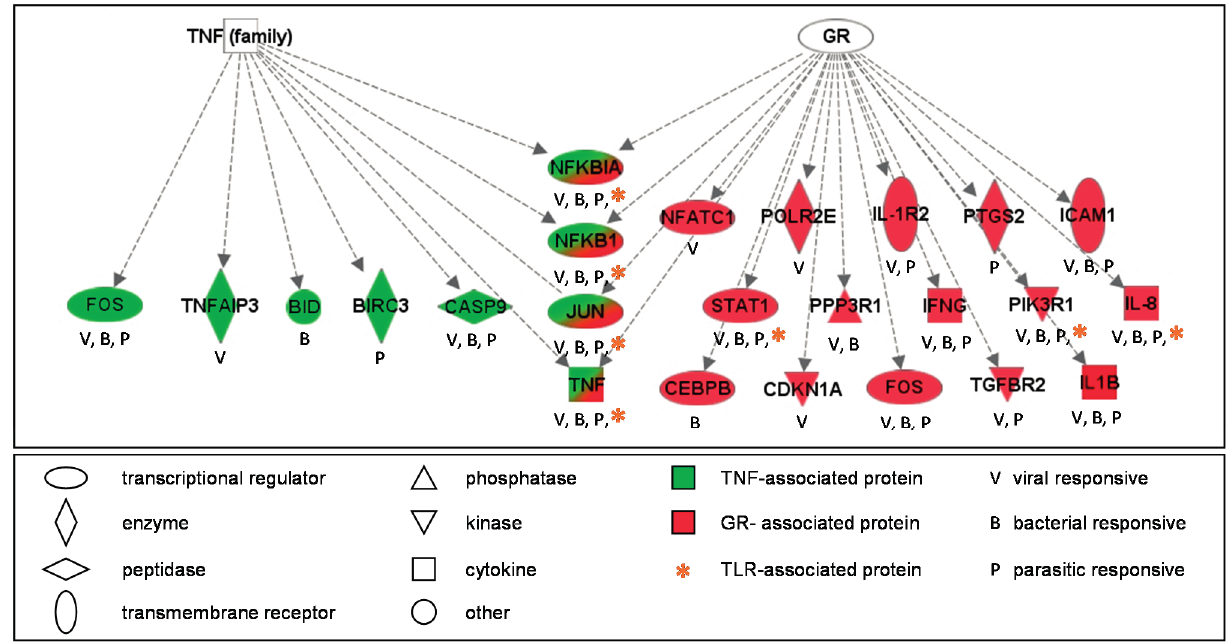
Figure 2. The glucocorticoid receptor (GR) signal transduction pathway is enriched within the infection and exposure-related gene networks. Proteins encoded by the IER genes are shown for those directly involved in the GR pathway and the associated tumor necrosis factor (TNF)